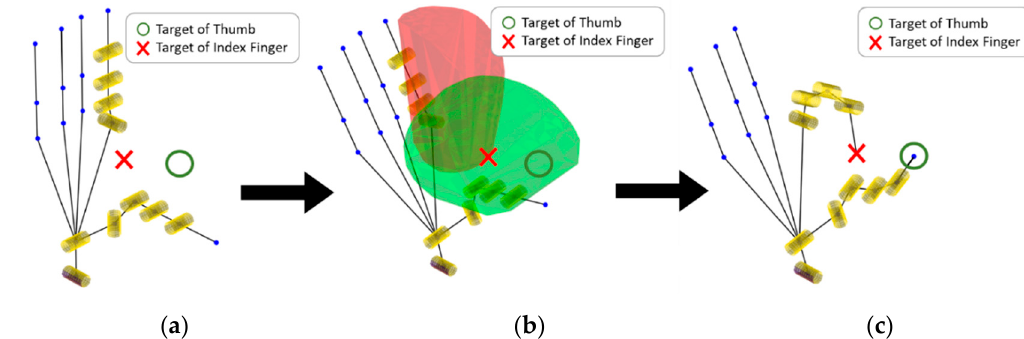
Figure 3. Process of the proposed algorithm: ( a ) assign inverse kinematics (IK) request; ( b ) feasibility check and generate wrist angle range; ( c ) perform immigration genetic algorithm (IGA) to obtain precise solution.